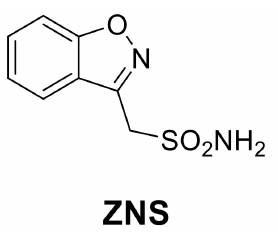
Figure 1. Structures of clinically approved Zonisamide ( ZNS ).